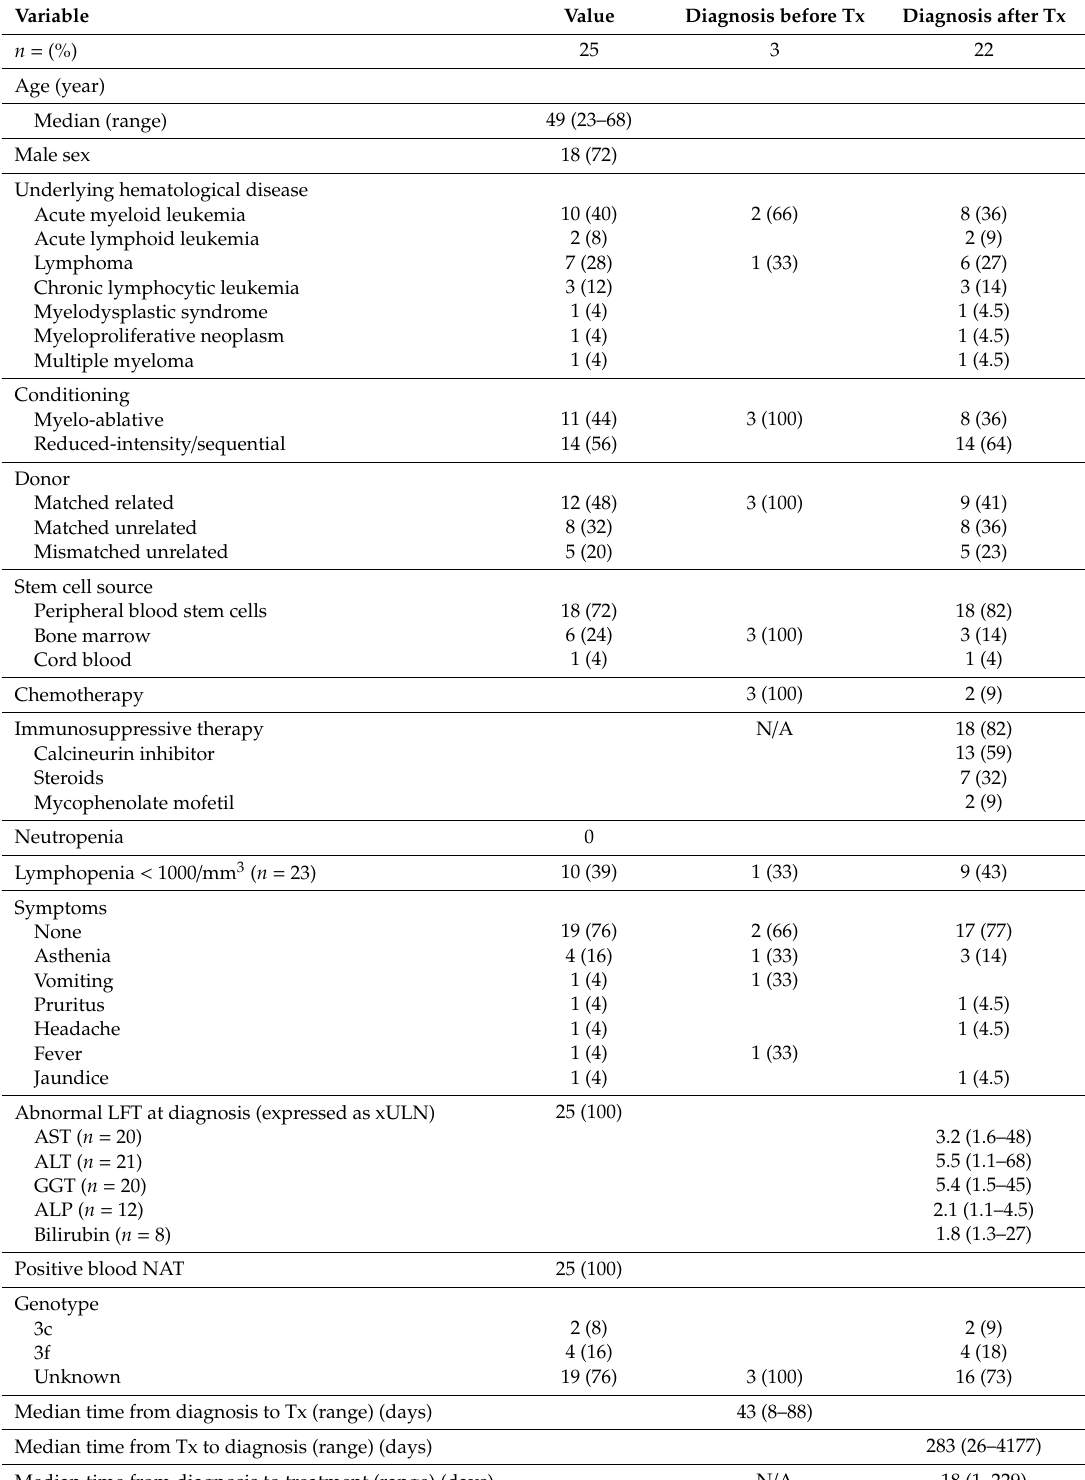
Table 1. Patient characteristics at